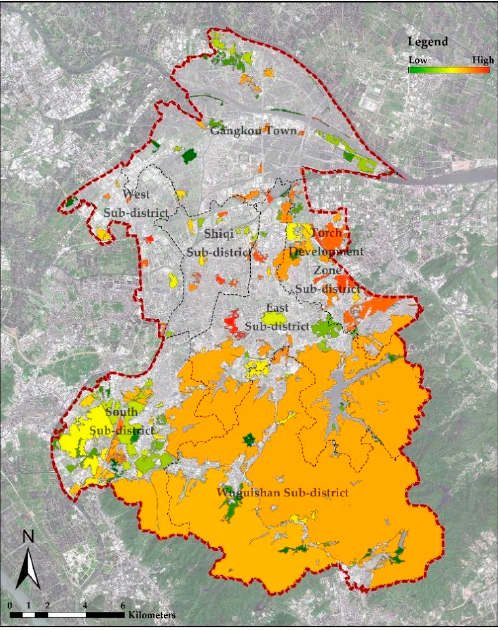
Figure 14. The landscape activity of UGI in the study area.